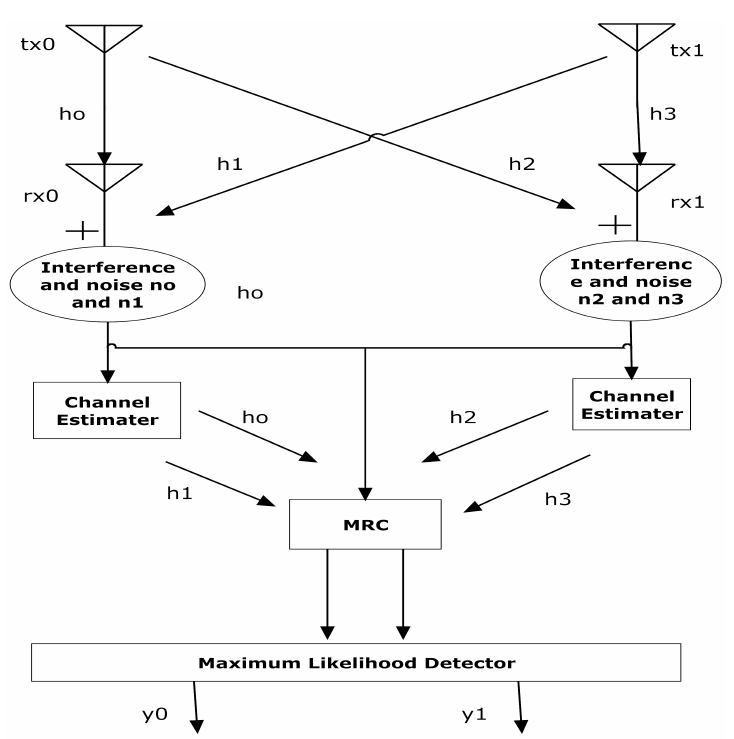
Figure 2. Alamouti space-time